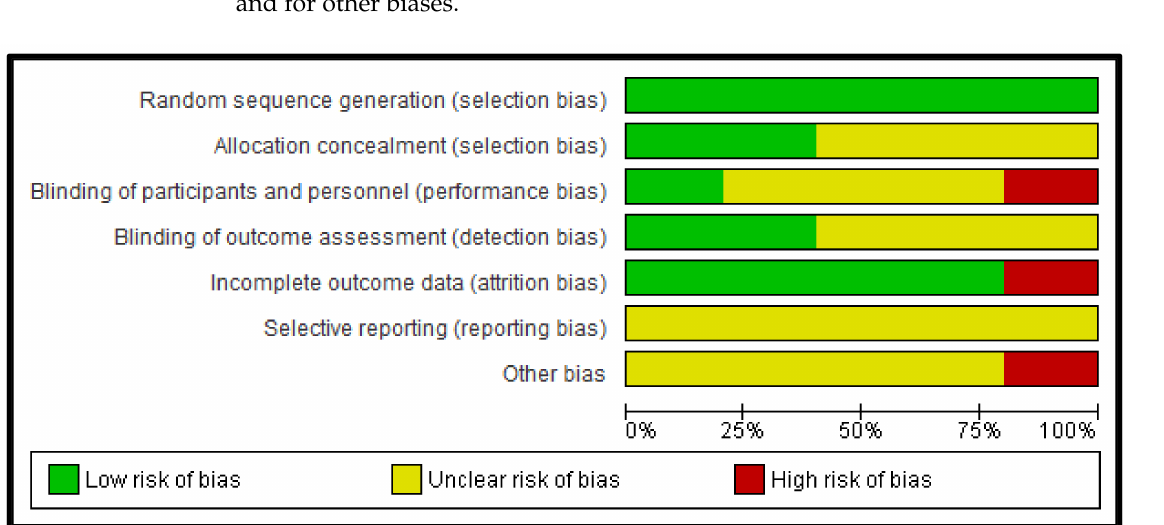
Figure 2. Evaluation of the general risk of